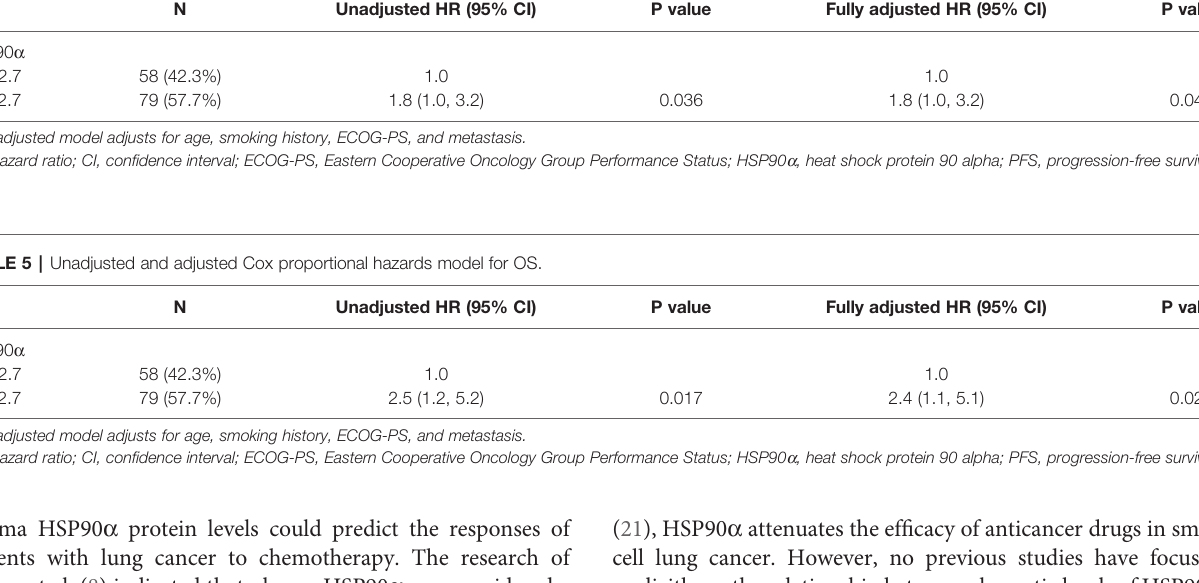
TABLE 4 | Unadjusted and adjusted Cox proportional hazards model for PFS. N Unadjusted HR (95% CI)